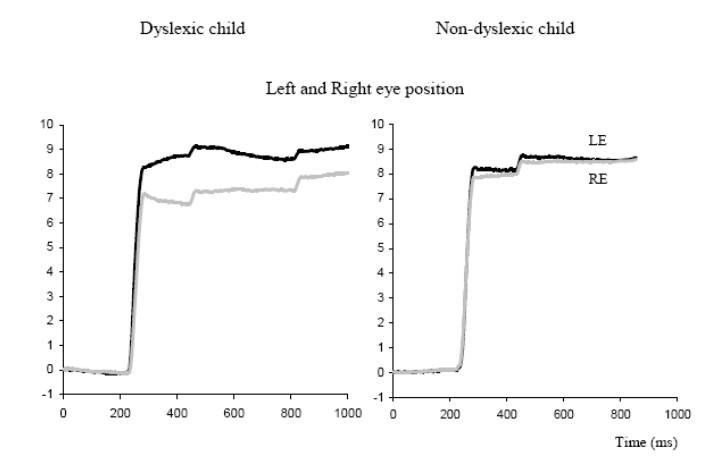
Figure 5. Binocular recordings of saccade during reading a word from a dyslexic and a non-dyslexic child. Individual eye posi- tions are shown for the left eye (dark trace) and the right eye (grey trace); the word appeared at time